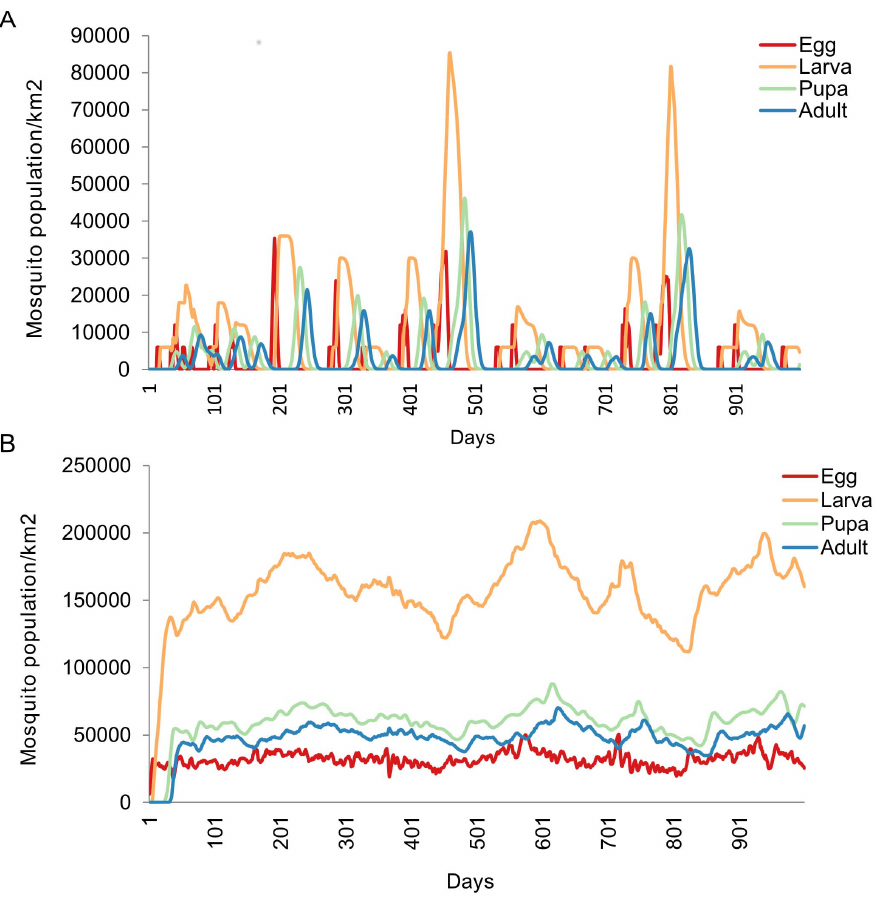
Figure 3. Simulated RVF vector population dynamics showing developmental stages from eggs, larvae, pupae and adults. (A) Floodwater Aedines depending on water level in breeding sites and host availability. (B) Culicines.